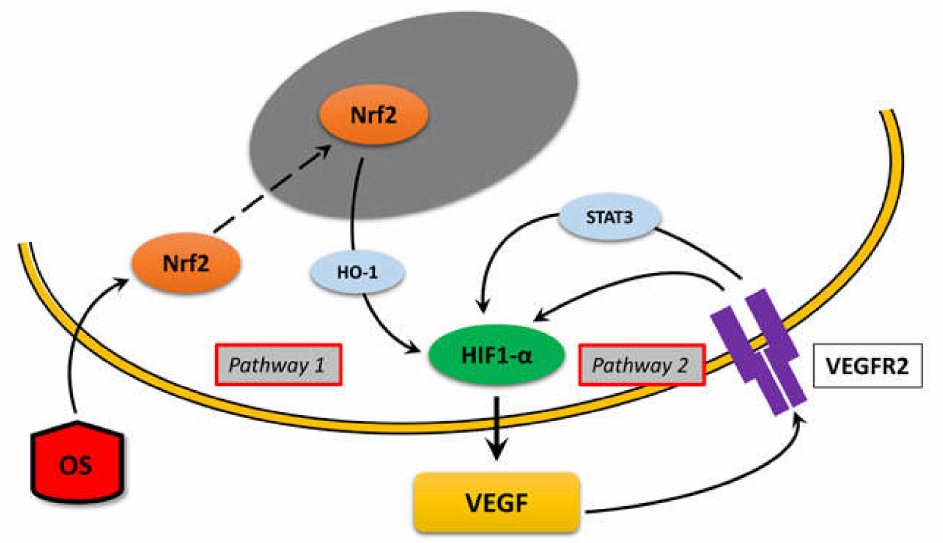
Figure 8. Schematic interpretation of the results of the present study and of other data in the literature showing the possible mechanism of an OS-induced VEGF autocrine loop in the retina. This mechanism can be divided into two parts (pathways). According to our observations, in “pathway 1”, OS triggers Nrf2 activation and nuclear translocation. In the nucleus, Nrf2 induces the expression of antioxidant genes, and in particular the one coding the HO-1 enzyme, which is reported in the literature to be able to stabilize HIF-1 α . For the sake of simplicity, the diagram does not indicate HIF-1 α or STAT3 nuclear translocation, induction of VEGF transcription, VEGF translation, or VEGF release, but simply indicates that HIF-1 α stabilization results in VEGF release. This activates “pathway 2”, in which the released VEGF would bind to VEGFR2, which in turn (likely through STAT3 activation, according to the literature) would again stimulate HIF-1 α stabilization and nuclear translocation for further VEGF expression and